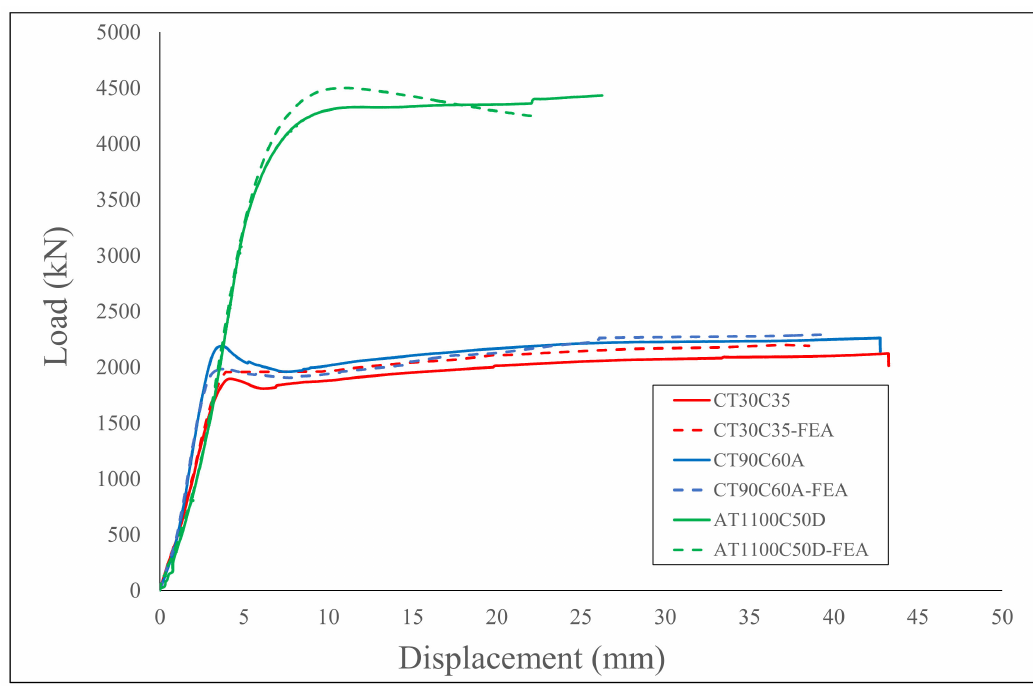
Figure 12. Comparison of typical load versus displacement